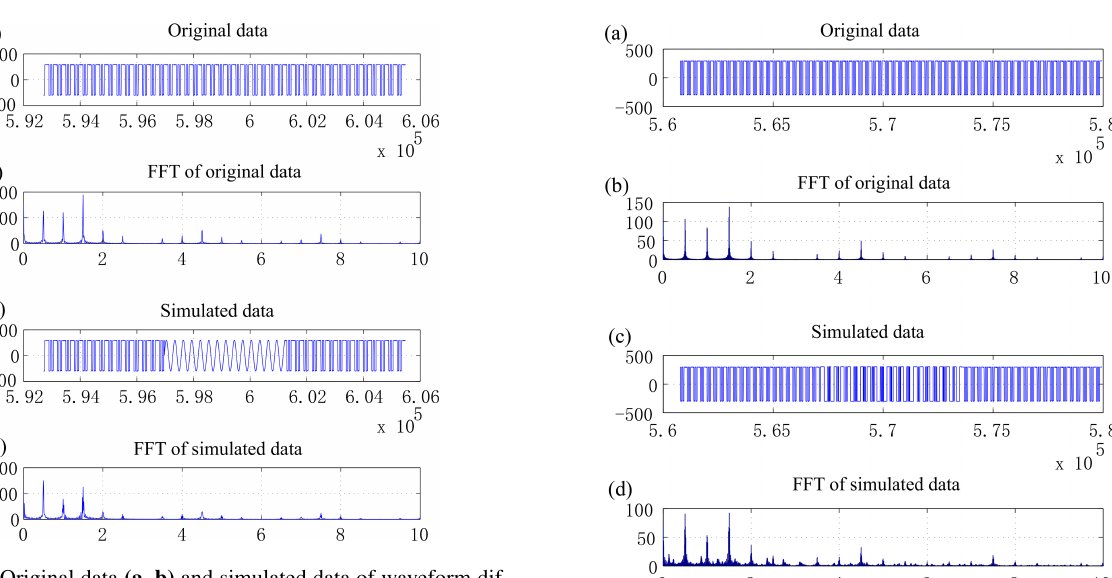
Figure 8. Original data (a, b) and simulated data of waveform dif- ference variation (c, d) .